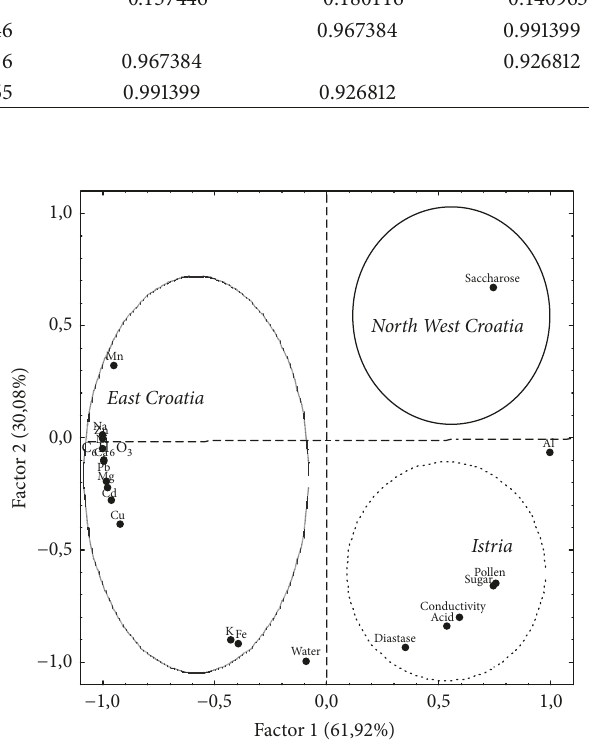
Figure 3: An overview of the PCA (Principal Component Analysis) of the chemical composition of acacia honey from three regions of the Republic of Croatia. Water: water %, Aci: free acids (mEq/100g), Conductivity: electrical conductivity (mS/cm), Sugar: reducing sugars (g/100g), Saccharose: saccharose (g/100g), Diastase: diastase (DN), and HMF: HMF